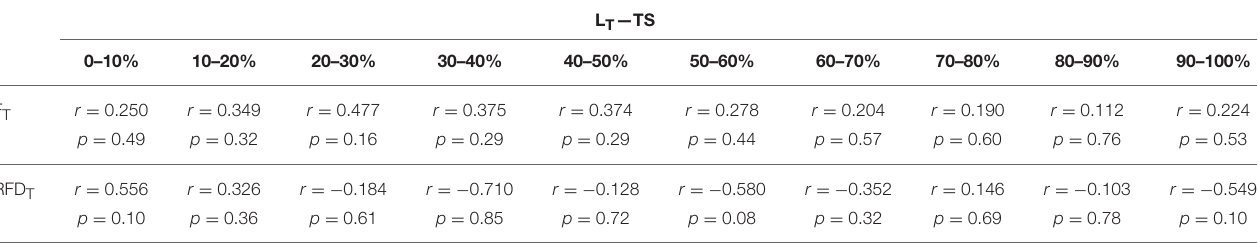
TABLE 3 | Relationship between quadriceps tendon length (L T ) and patellar tendon force magnitude (F T ) and rate (RFD T ) during a loaded fixed tempo squat (TS).